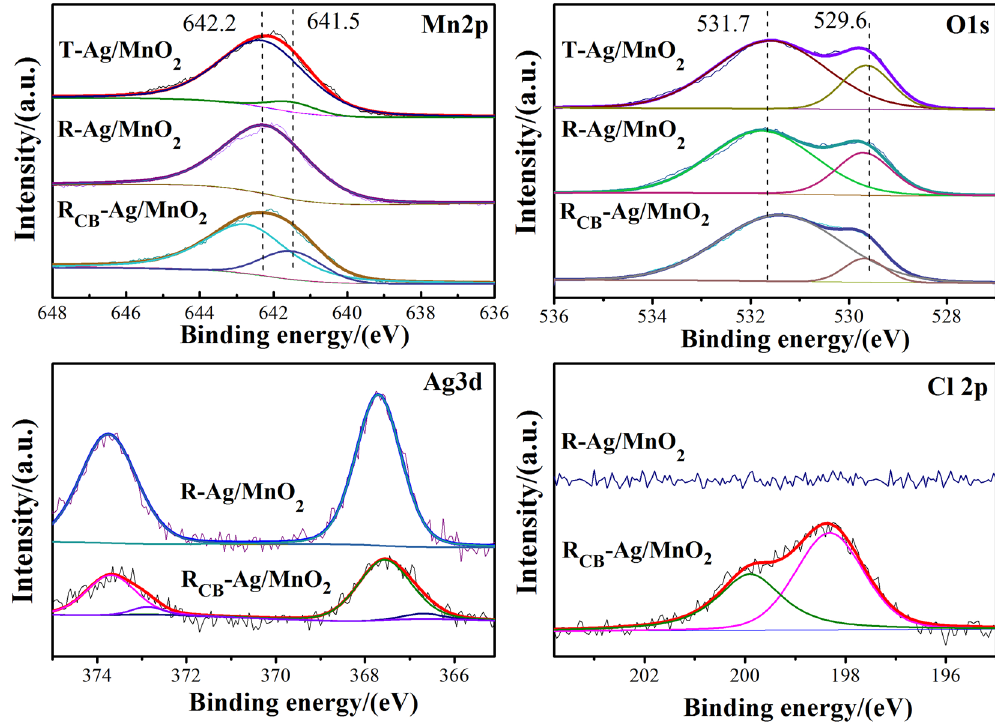
Figure 9. Mn 2p, O 1s, Ag 3d and Cl 2p XPS spectrum of Ag/MnO 2 .